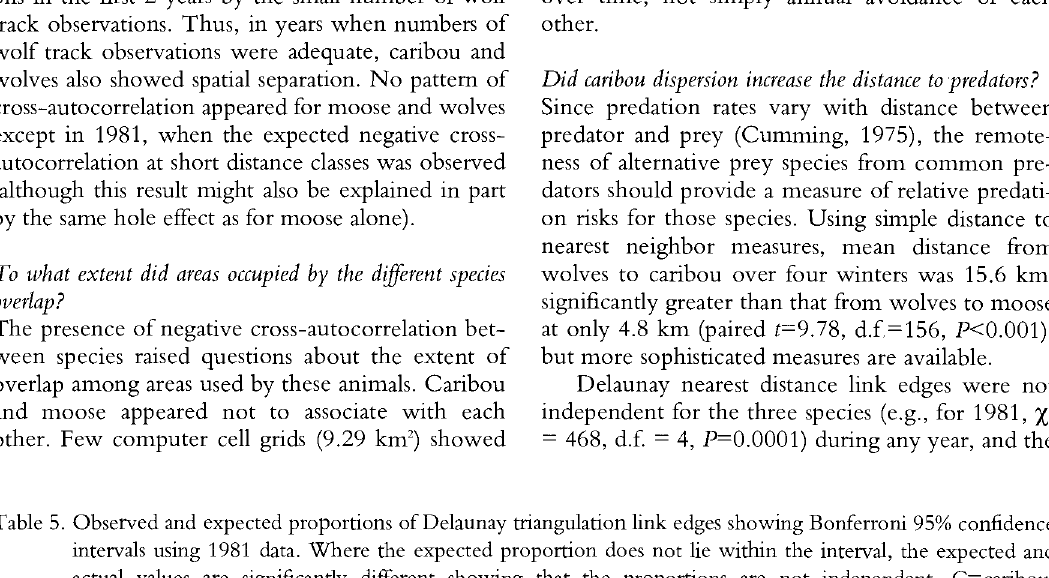
Table 5. Observed and expected proportions of Delaunay triangulation link edges showing Bonferroni 95% confidence intervals using 1981 data. Where the expected proportion does not lie within the interval, the expected and actual values are significantly different showing ; that the proportions are not independent. C=caribou, M=moose, P= •predator (gray